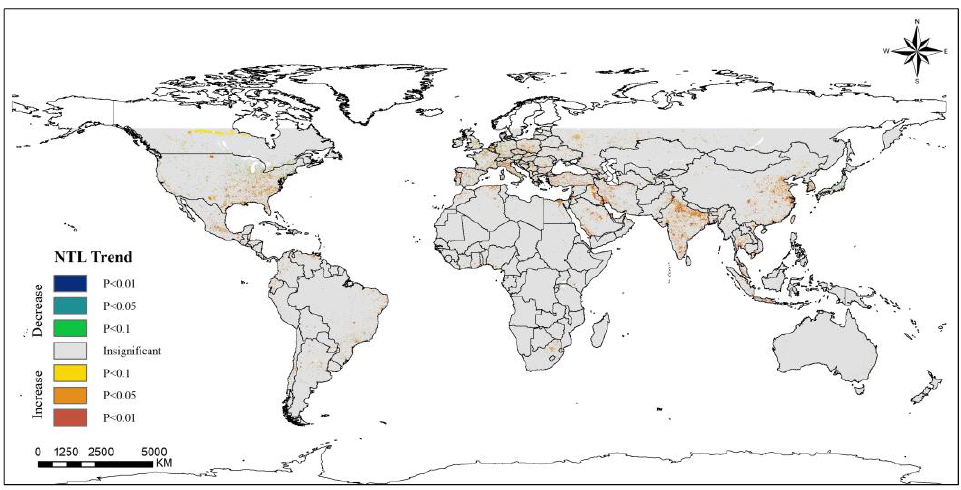
Figure 10. Spatiotemporal trends of NTL throughout the world (2000 – 2019).